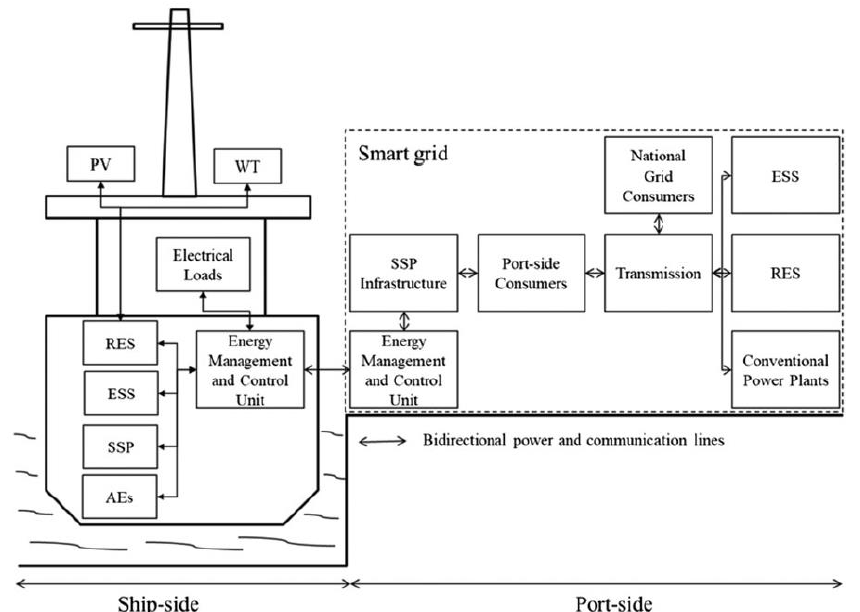
Figure 22. SSP connections with smart-grid. Reprinted with permission from ref. [103]. Copyright © 2018 John Wiley & Sons, Ltd.